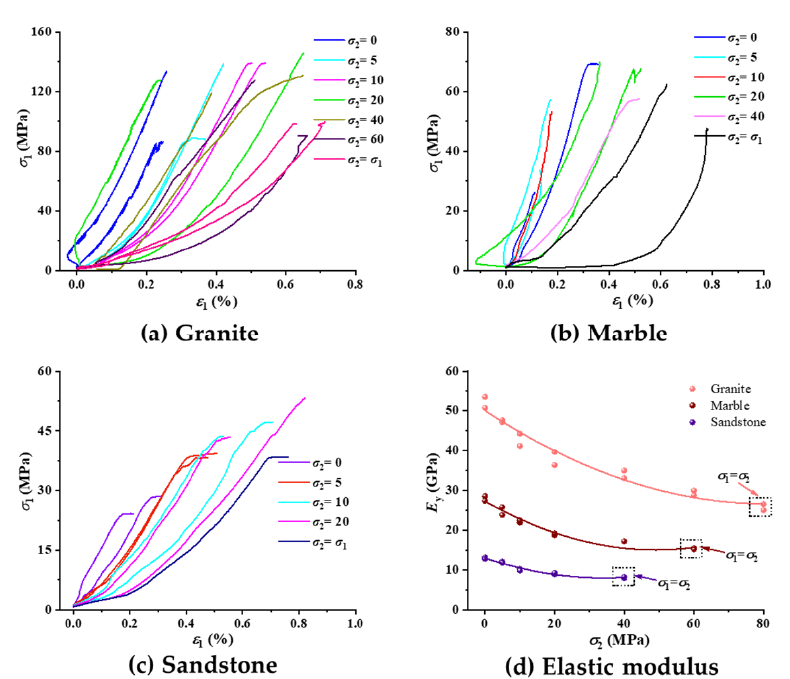
Figure 6. Axial stress–strain curves of rock specimens including ( a ) granite, ( b ) marble, ( c ) sandstone, and the ( d ) elastic modulus.